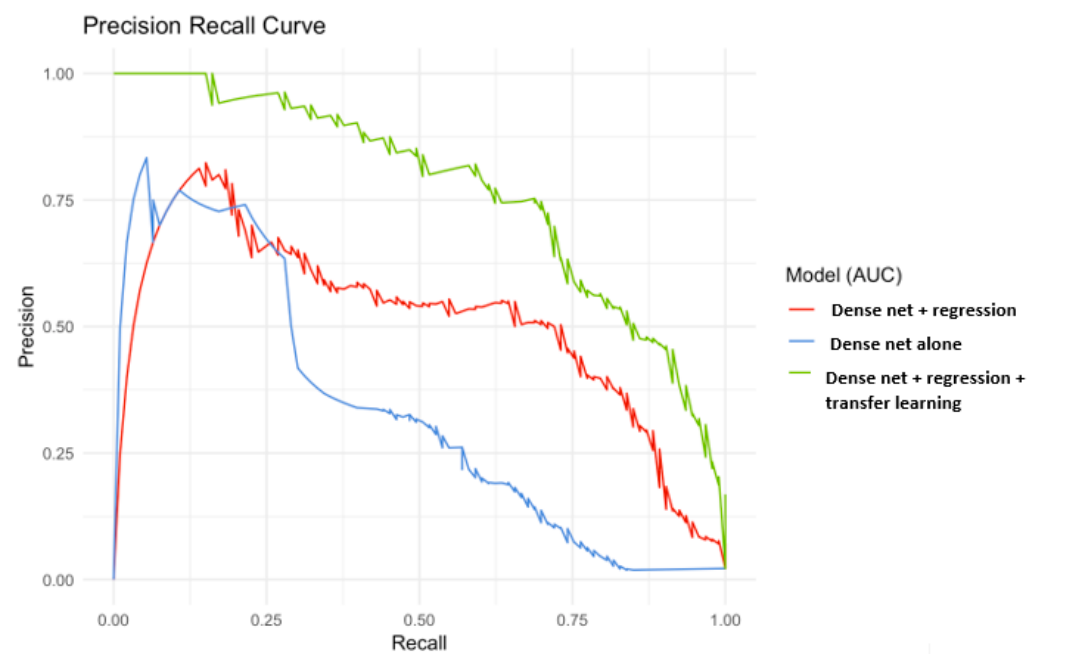
Figure 10. Precision versus recall of the Dns-Net model with regression inferring the transfer learning effect, the precision increased with the transfer learning. The highest area under the ROC curve is 0.98 for the normal case (no ‐ defect struc ‐ tures). The lowest area of 0.90 for the pristine case of crystal structures. By employing the